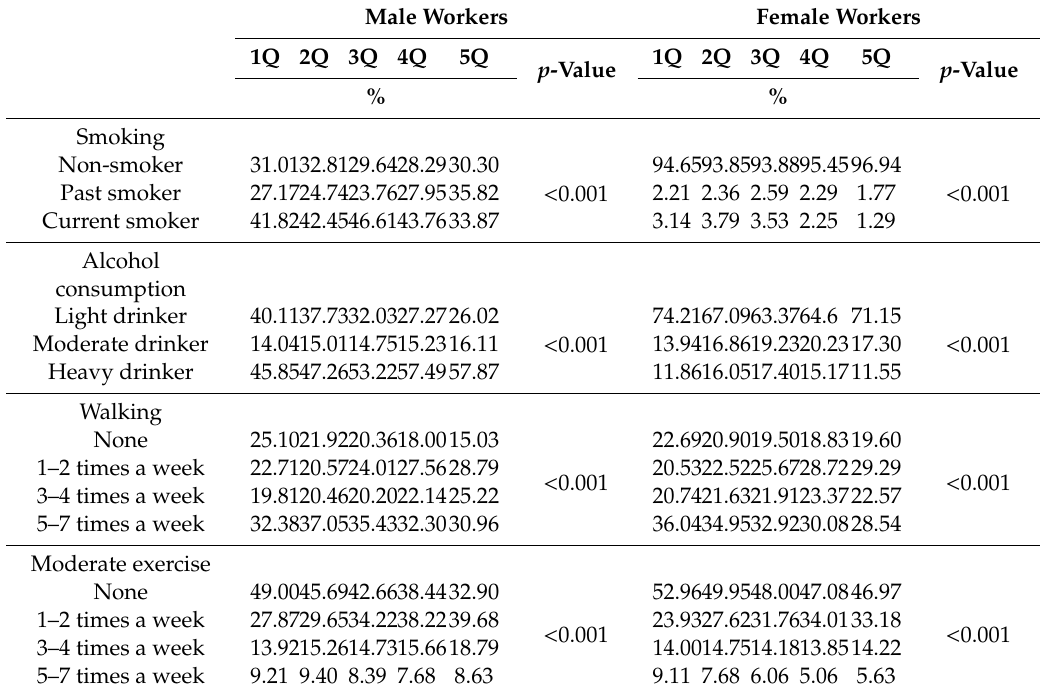
Table 3. Sex di ff erences of health behavior by